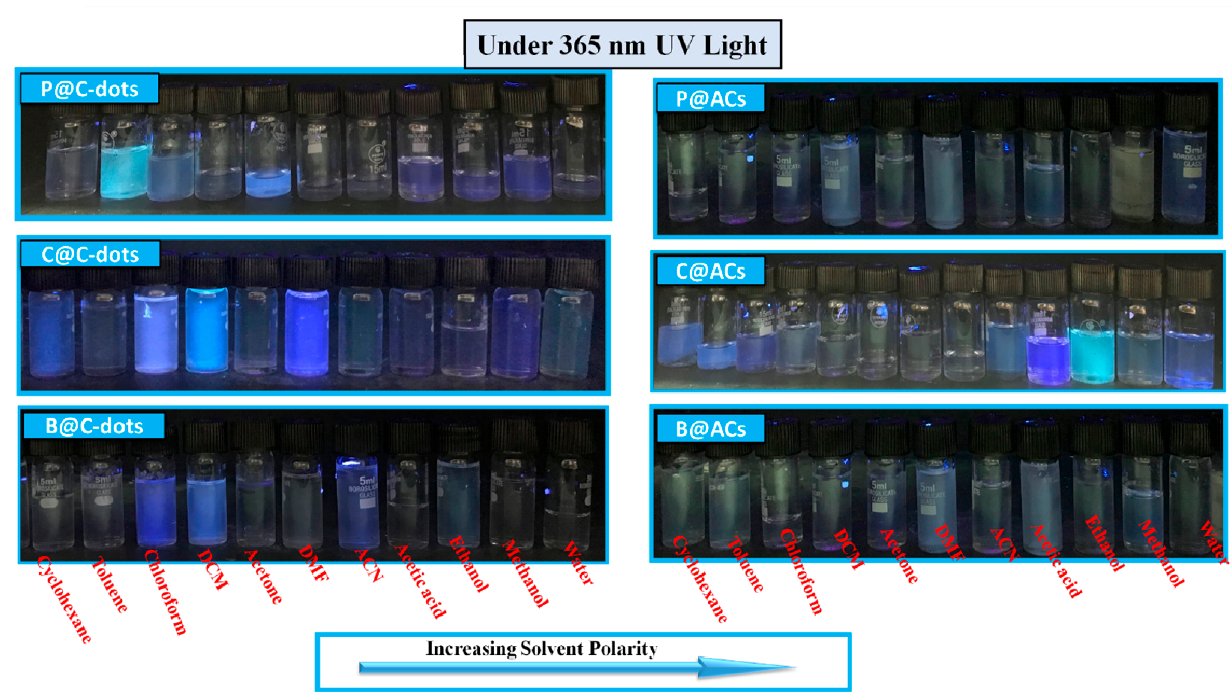
Figure 6. UV-visible spectra of ( a ) P@CQDs, ( b ) C@CQDs, ( c ) B@CQD in presence of polar protic solvents including methanol, ethanol and acetic acid.